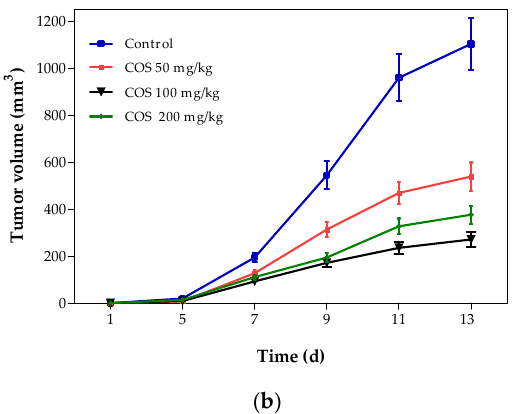
Figure 4. Effects of COS foods on the trend changes of body weight ( a ) and tumor volume ( b ) of tumor-bearing mice. Data represents mean ± SD, n = 12.